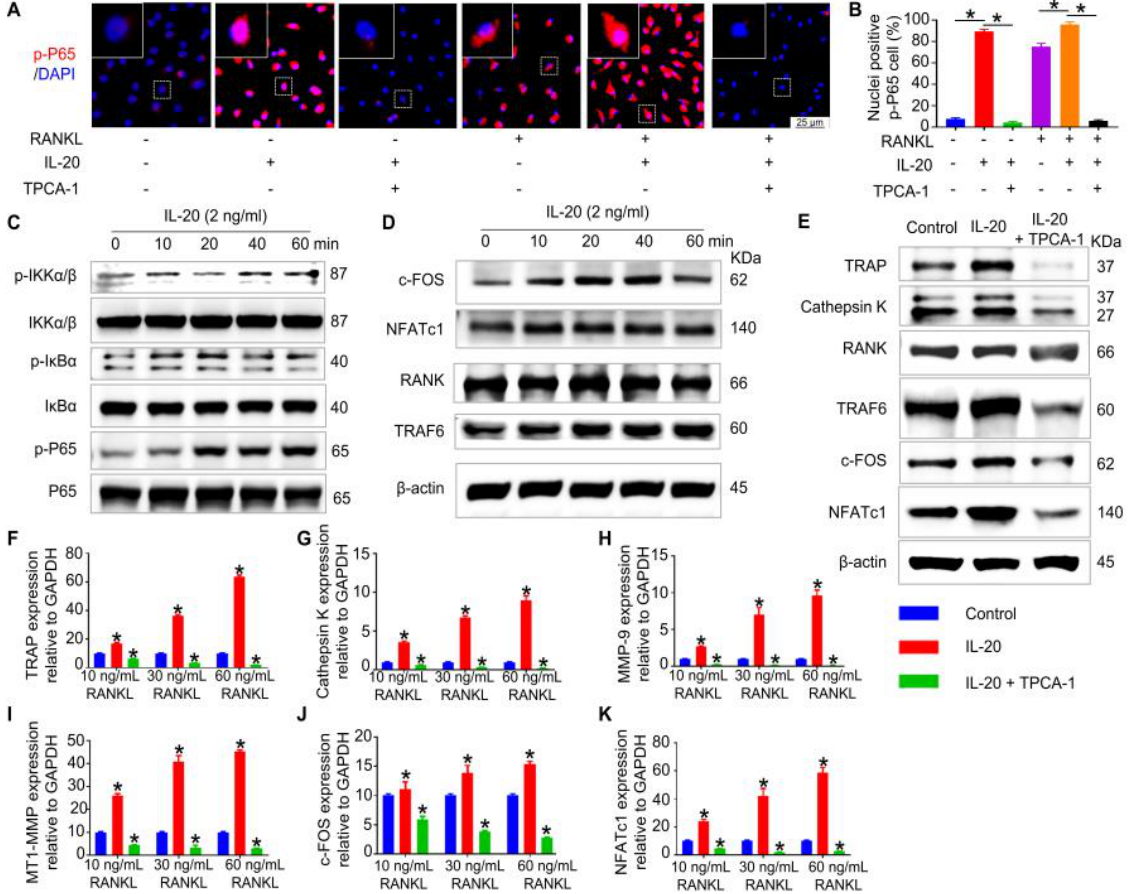
Figure 5. IL-20 promoted the expression of osteoclast-specific genes and proteins via NF- κB pathway during RANKL-induced osteoclast differentiation. Preosteoclasts were stimulated with IL-20